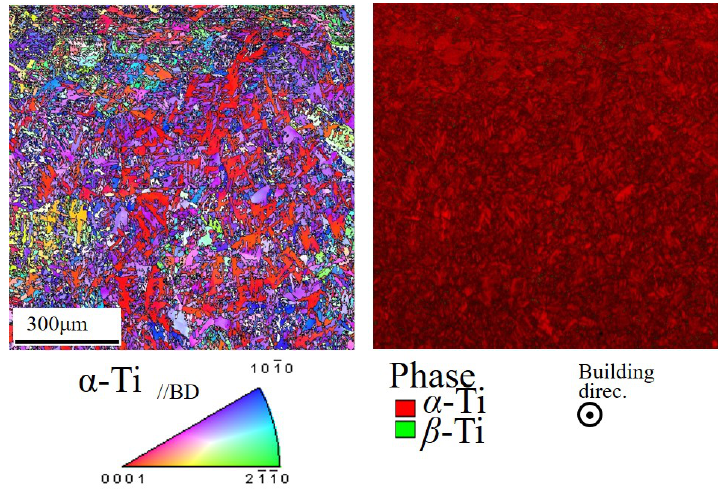
Figure 11. Build direction (BD) inverse pole figure map and phase map of the as-built material. The cooling rate in the heating experiment in this study is about 4 ◦ C/s (from 750 ◦ C to 300 ◦ C) and, therefore, is much lower than in the EB-PBF process, where the martensitic phase does not occur. A careful inspection of the inverse pole figure map (Figure 9a) revealed that fine α grains found in the as-built sample disappear after the transformation from β phase, leading to a more homogeneous and larger grain size of the α phase as shown in Figure 12a.